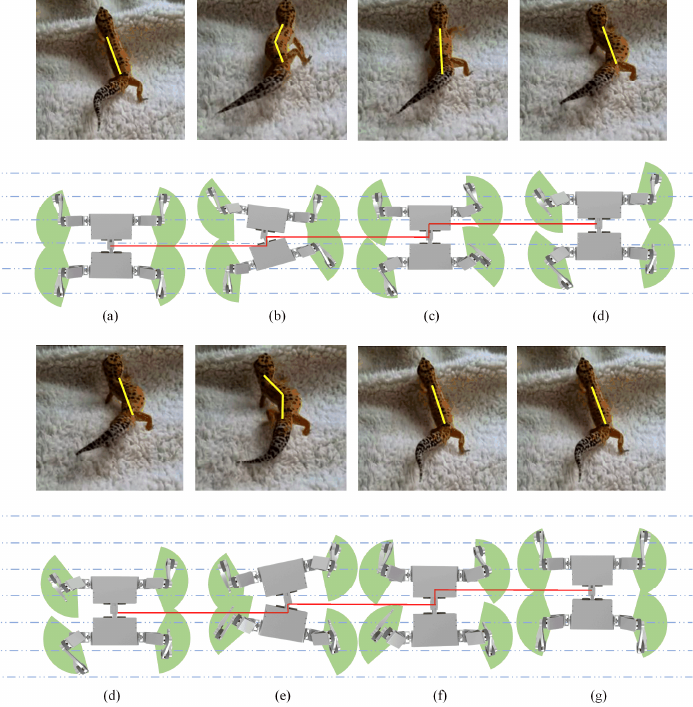
Figure 6. Walking Gait of the Robot: ( a ) At the initial stage, the robot trunk is rectangular, and four legs are evenly distributed on both sides of the trunk; ( b ) The body twists by an angle θ and moves forward for a certain distance, and leg 4 steps forward at the same time; ( c ) The body twists back to its original posture and moves forward for a certain distance, and leg 2 steps forward at the same time; ( d ) The positions of foot endpoints remain unchanged, and the body keeps a rectangular posture to move forward for a certain distance; ( e ) The body twists by an angle - θ and moves forward for a certain distance, and leg 3 steps forward at the same time; ( f ) The body twists back to its original posture and moves forward for a certain distance, and leg 1 steps forward at the same time; ( g ) The positions of foot endpoints remain unchanged, and the body keeps a rectangular posture to move forward for a certain distance.